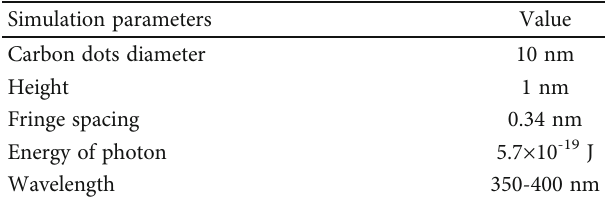
Table 1: Simulation